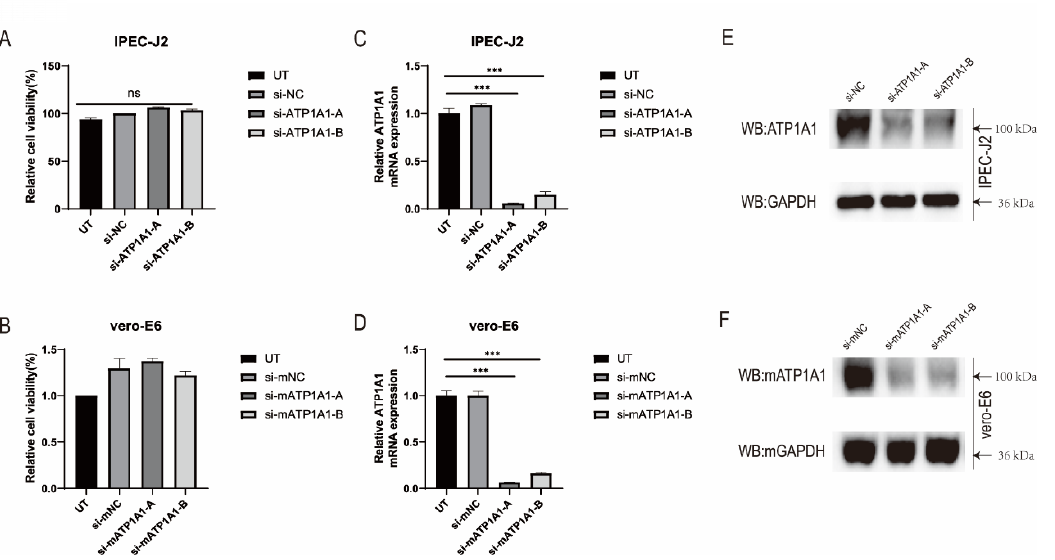
Figure 2. ATP1A1 knockdown by siRNAs transfection. ( A , B ) The cytotoxicity of siRNAs. IPEC-J2 and Vero-E6 cells were transfected with siRNAs against ATP1A1 for 48 h and analyzed using the CCK-8 kit. Data represent means ± SD from three independent experiments. ns, no significant difference. ( C , D ) Relative quantification of ATP1A1 mRNA. Cells were transfected with siRNAs against ATP1A1 for 48 h. Total cellular RNA was extracted, reverse transcribed, and quantified. The siRNA-NC or siRNA-mNC assigned the value of 1.0, data represent means ± SD from three independent experiments. *, p < 0.05; **, p < 0.01; ***, p < 0.001; ****, p < 0.0001. ( E , F ) Western blot analysis of ATP1A1 protein expression. The cells were lysed after 48 h of interference and Western blot was performed using rabbit anti-ATP1A1 mAb and mouse anti-GAPDH mAb. Detection using the corresponding secondary antibody.